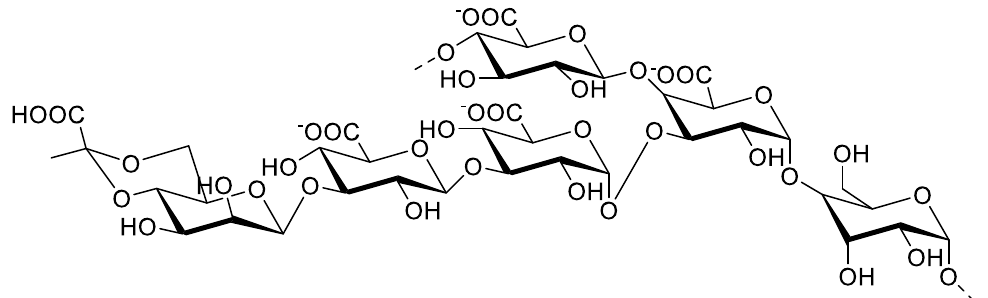
Figure 7. Monomeric unit of exopolysaccharides obtained from the Alteromonas macleodii subspecies fijiensis [81].